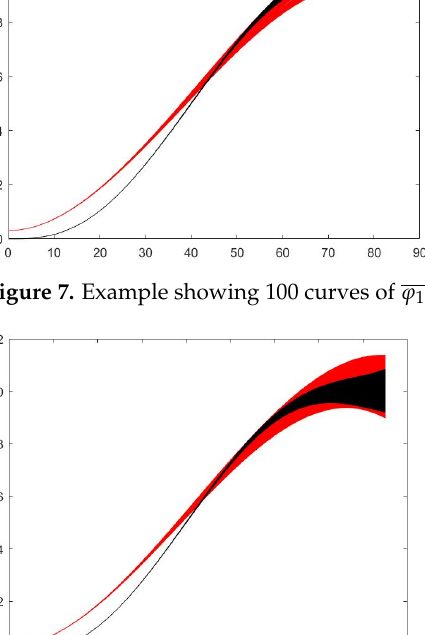
Figure 8. Example showing 10,000 curves of ϕ 1 and ϕ 2 .